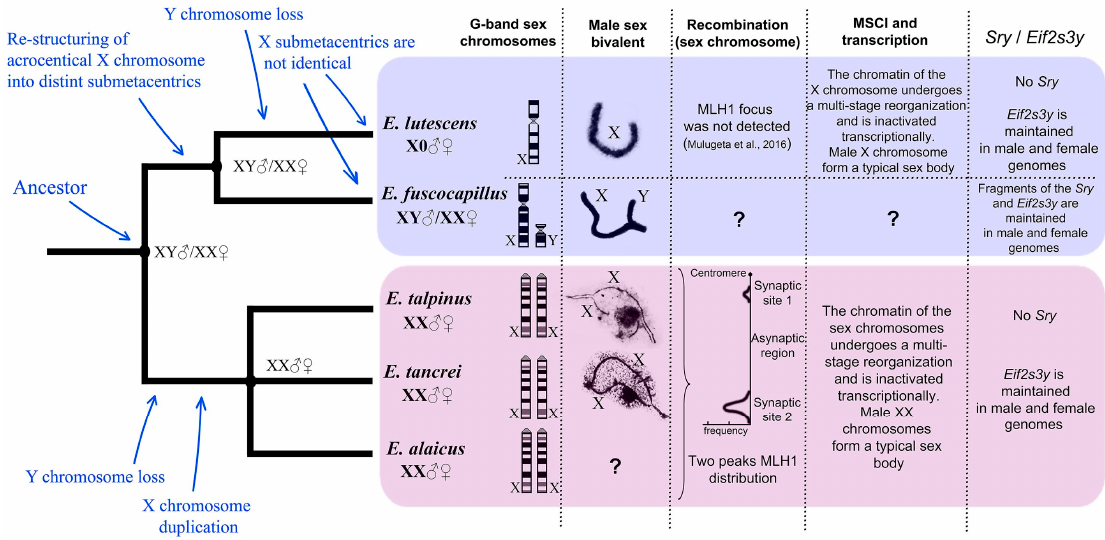
Figure 6. Evolutionary patterns of sex chromosome composition. G-Band: Giemsa band; MSC: meiotic sex chromosome inactivation.